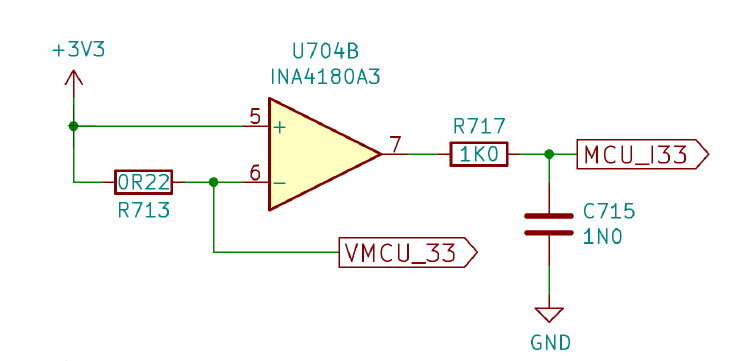
Figure 5. Schematic of a DSO supply current input